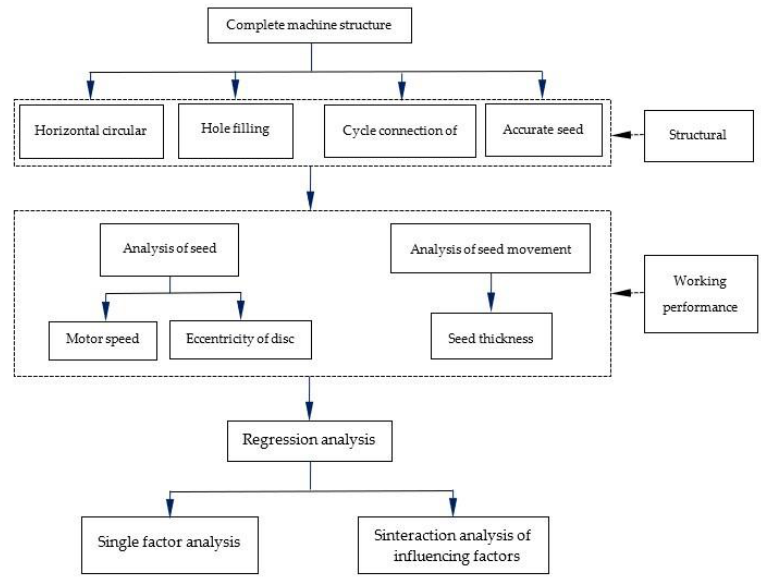
Figure 1. Workflow of this article.